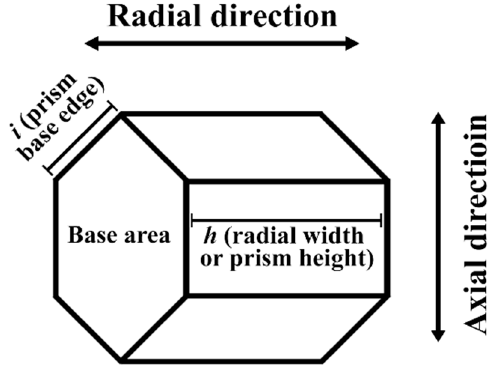
Figure 2. Three-dimensional illustration of a cork cell as a hexagonal prism (modified from Miranda et al. [ Error! Reference source not found. ]).